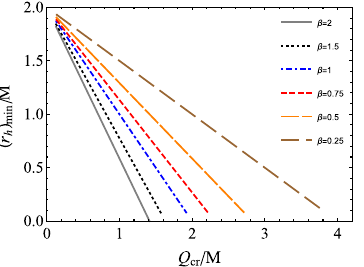
Fig. 2 The minimum radius of the outer horizon as a function of the critical BH charge Q cr , at the corresponding upper values of the param- eter γ for different values of the parameter β